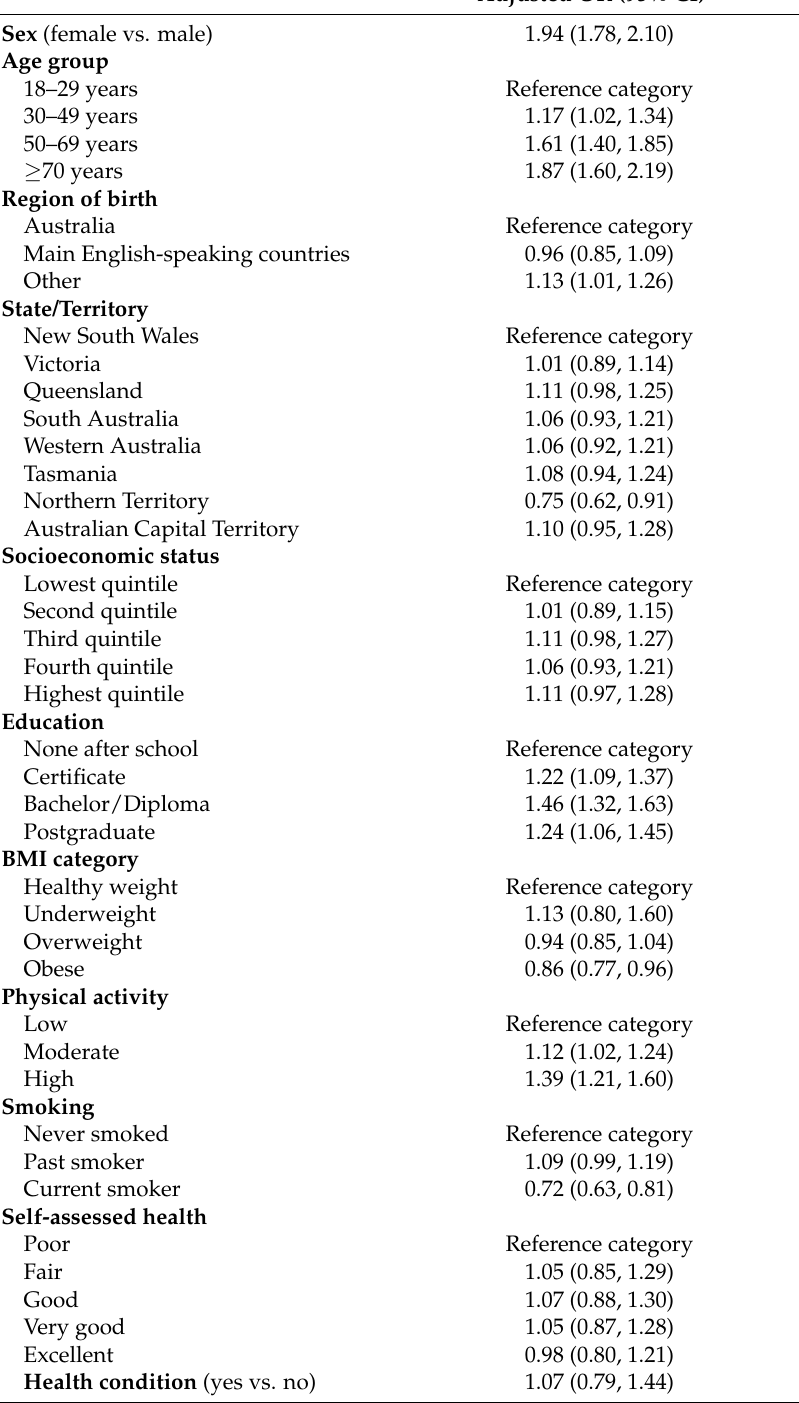
Table 1. Adjusted logistic regression investigating independent predictors of dietary supplement use in Australian adults aged ≥ 18 years ( n =